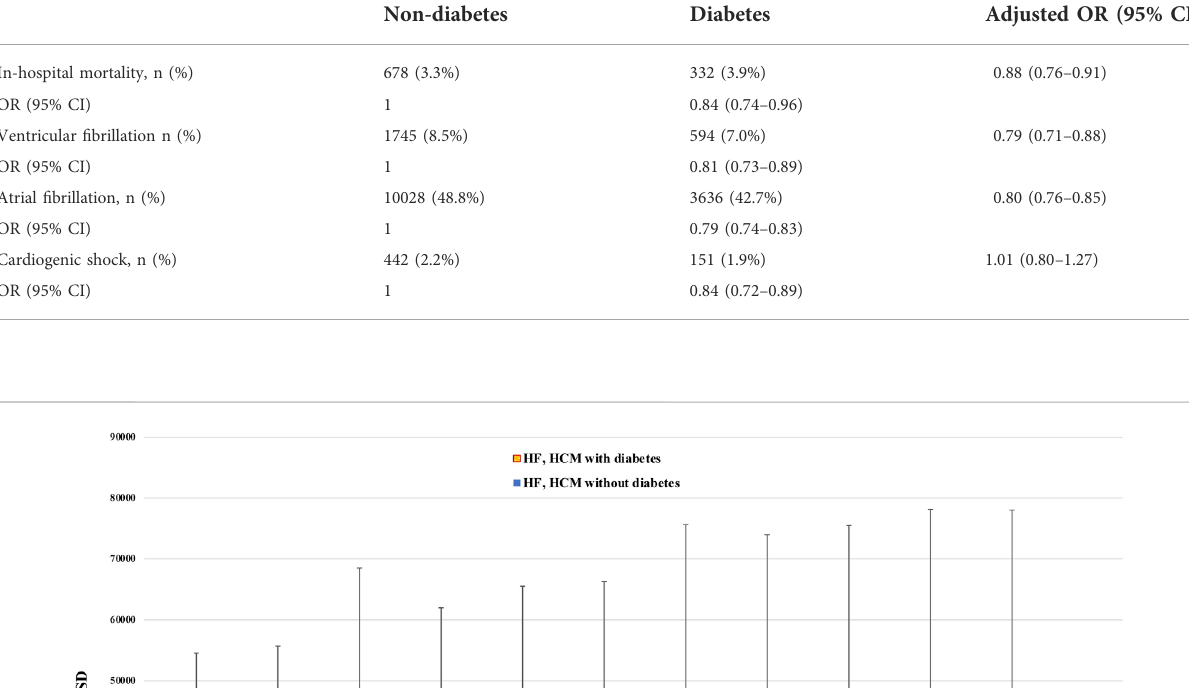
TABLE 4 Cardiovascular outcomes of patients with heart failure and hypertrophic cardiomyopathy, with and without diabetes.